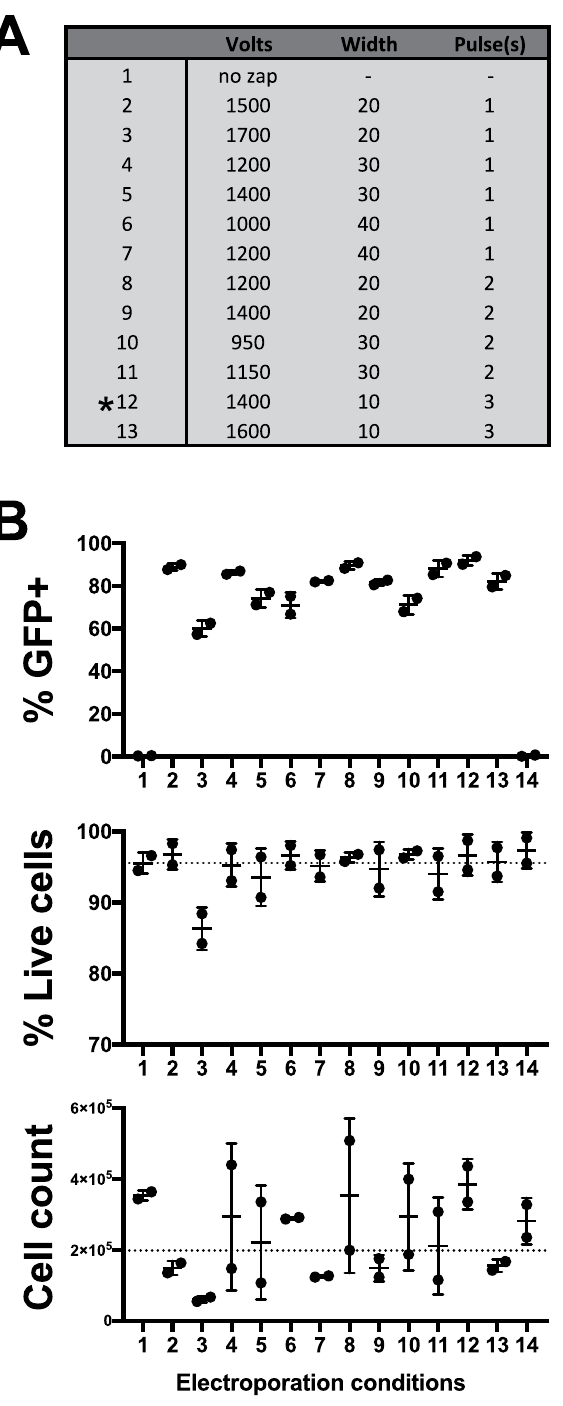
Figure 2. Electroporation conditions affect B cell transfection efficiency, viability, and post transduction expansion. ( A ) Table of electroporation conditions tested. ( B ) The percentage of B cells transfected with chemically modified EGFP coding mRNA (upper panel) as well as post transfection cell viability ( middle panel ) and expansion ( lower panel ) (n = 2). Dashed lines indicate pre-electroporation viability and cell